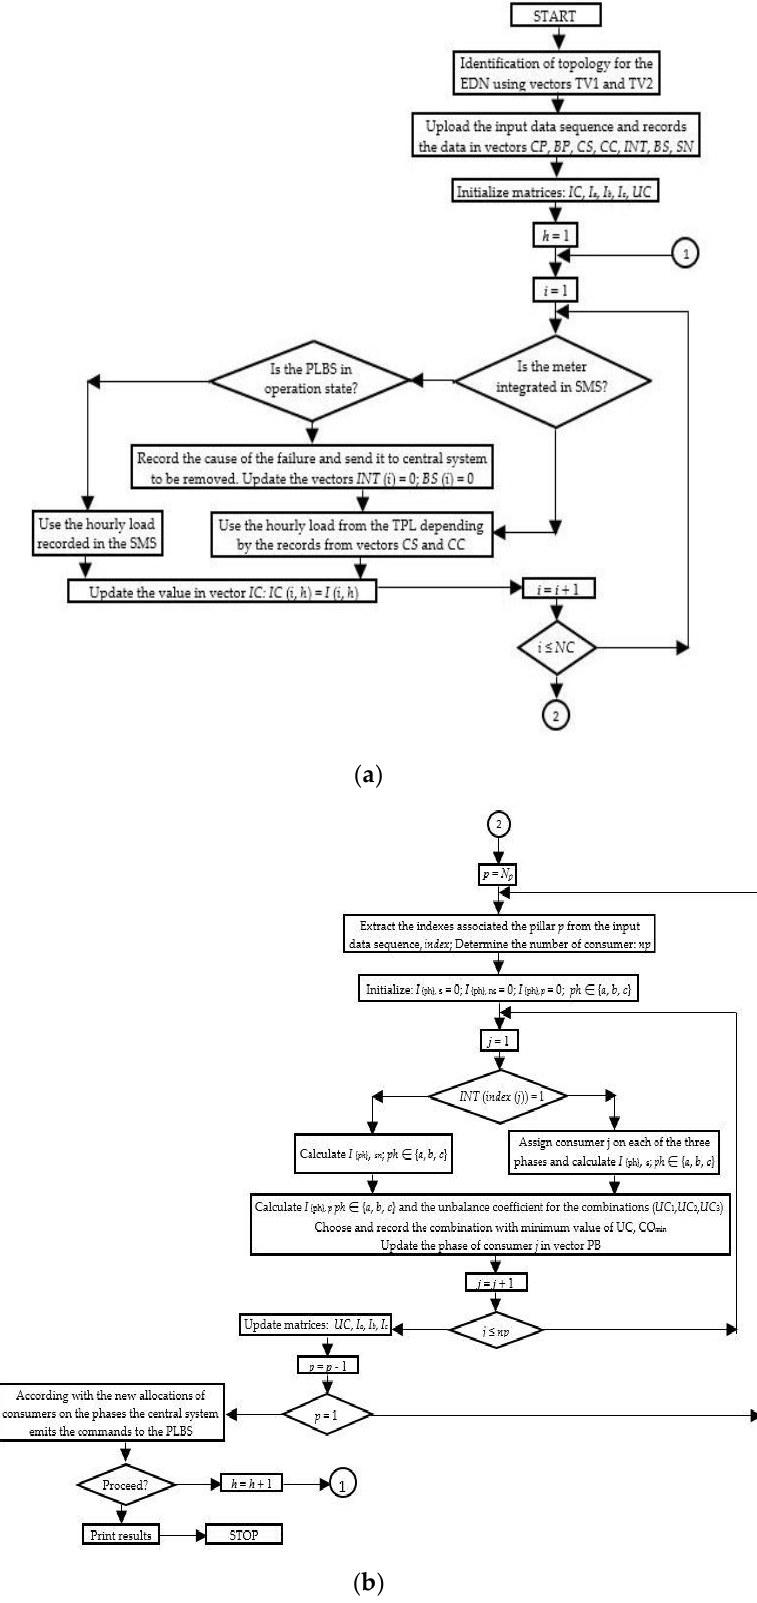
Figure 7. ( a ) The flow-chart of the proposed algorithm (the first step—identification of the topology and second step—upload the input data sequence). ( b ) The flow-chart of the proposed algorithm (the third step—PLB sequence).